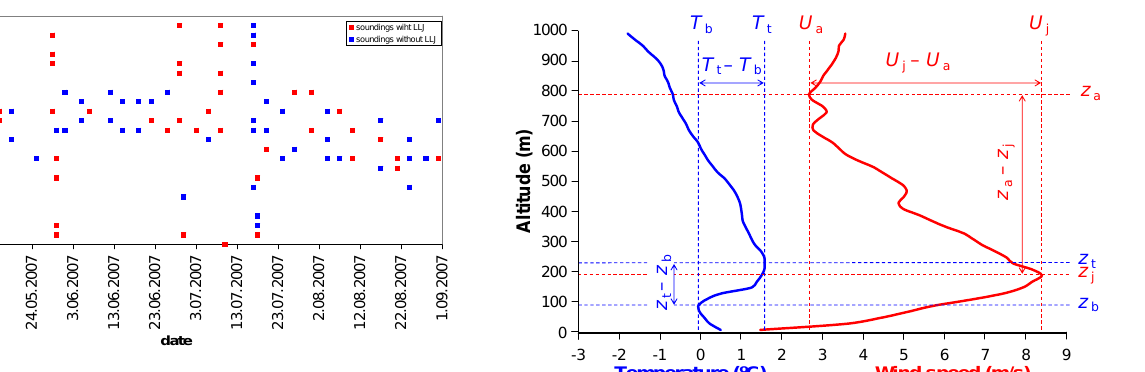
Fig. 2. Temporal distribution of Tara soundings from 25 April to 31 August, 2007. Soundings with a LLJ are marked with red and without a LLJ with blue.